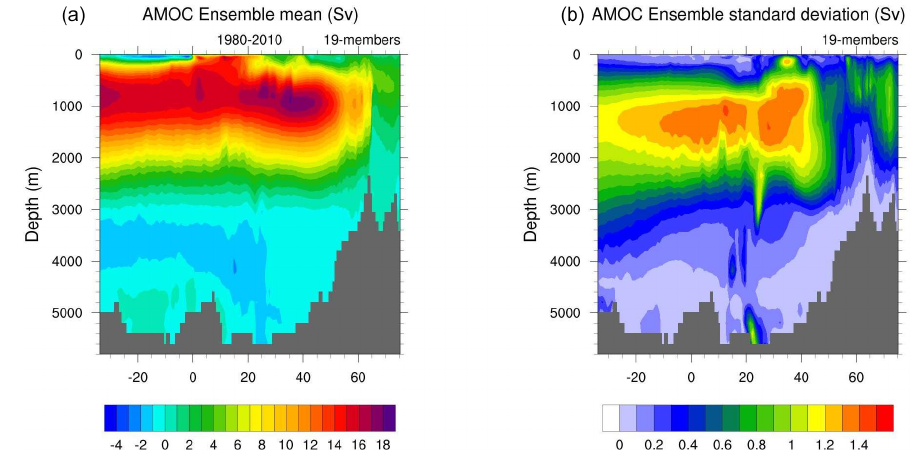
Figure 15. (a) AMOC stream function in the depth and latitude plane for the EC-Earth3 ensemble mean, averaged over 1980–2010 (in Sv). (b) Standard deviation of AMOC between the members. The x axis denotes degrees latitude.